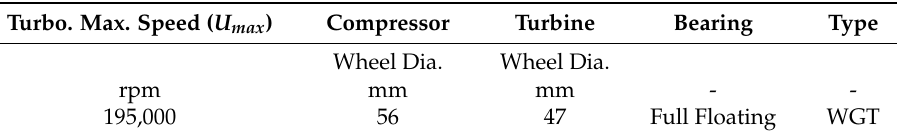
Table 3. Experimental turbocharger specification